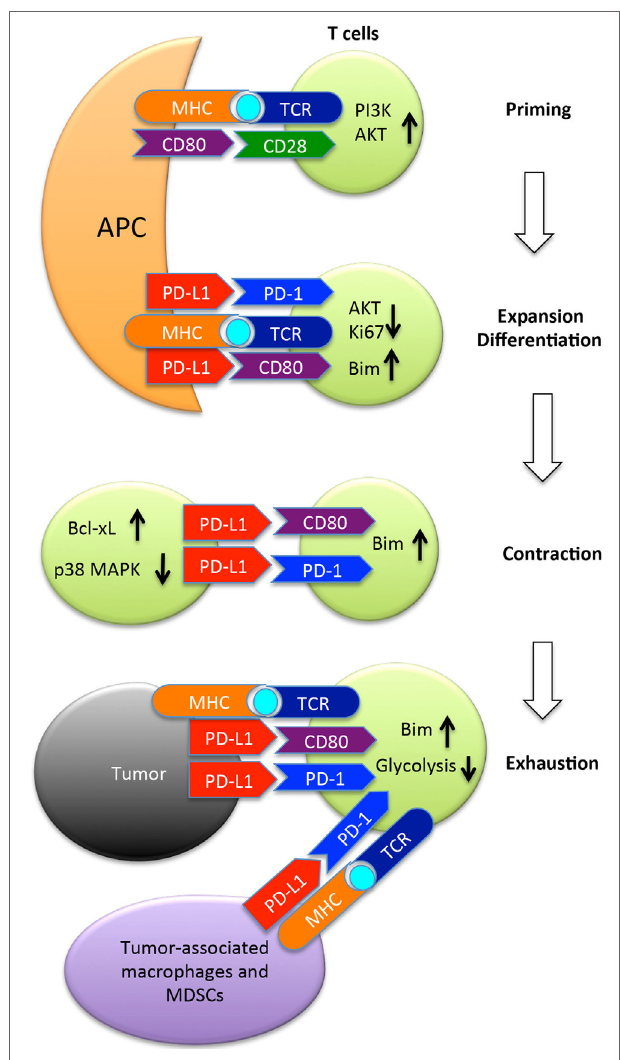
FigURe 1 | The programmed death ligand-1 (PD-L1) (B7-H1) pathway in regulation of T cell responses to tumors. Once naïve T cells encounter cognate antigen presented by antigen-presenting cells (APC), they are primed and express PD-1 and CD80, two receptors of PD-L1. PD-1 once engaged by its ligand recruits the phosphatase SHP-2 to inhibit AKT activation by preventing CD28-mediated activation of PI3K. Along with CD80, PD-1 suppresses T cell expansion, and limits differentiation to memory cells by upregulation of Bim. Following expansion, T cells undergo contraction in which PD-L1 expressed by activated T cells provides pro-survival signals to T cells by upregulating Bcl-xl and inhibiting p38 MAPK activation. After arriving at the tumor site, PD-L1 expressed by tumor cells or tumor- associated macrophages or MDSCs suppresses the function of tumor- reactive T cells by inducing either apoptosis or exhaustion. MDSC, myeloid-derived suppressor cells; Bim, Bcl-2-like protein